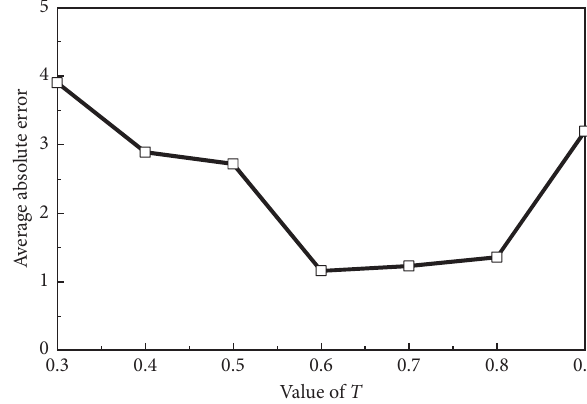
Figure 6: Absolute error of the measurement.